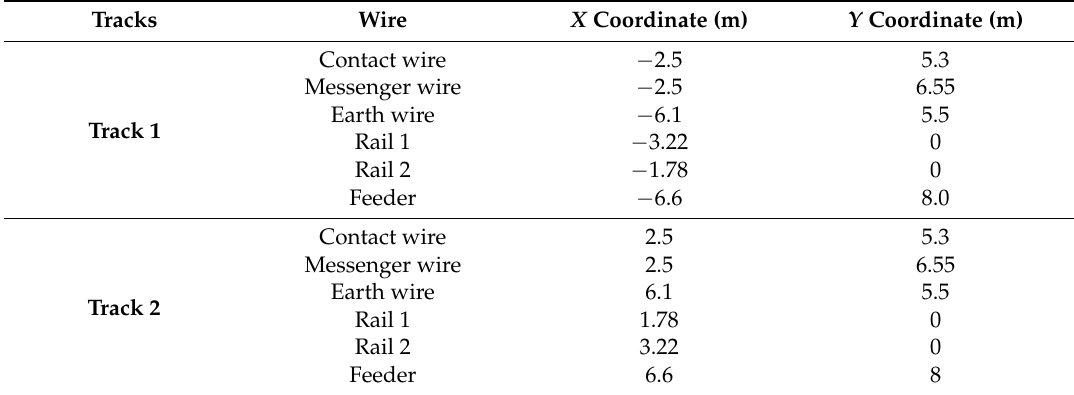
Table 2. Wires and rail positions on an Italian high-speed line built on an embankment.